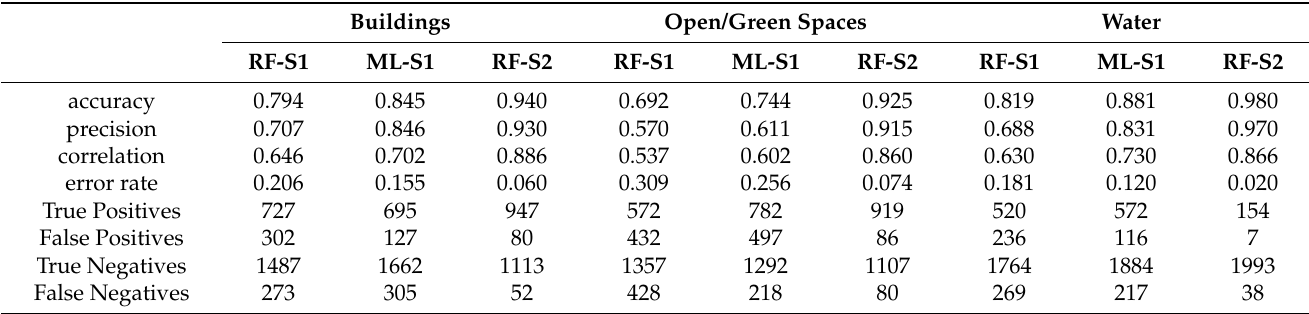
Table 2. Training accuracy metrics for the three classifiers.